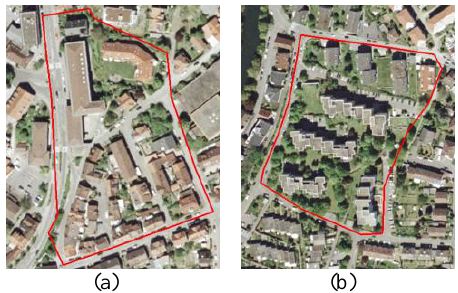
Figure 1. Images of Vaihingen test areas from Google earth. (a) Area 1. (2) Area